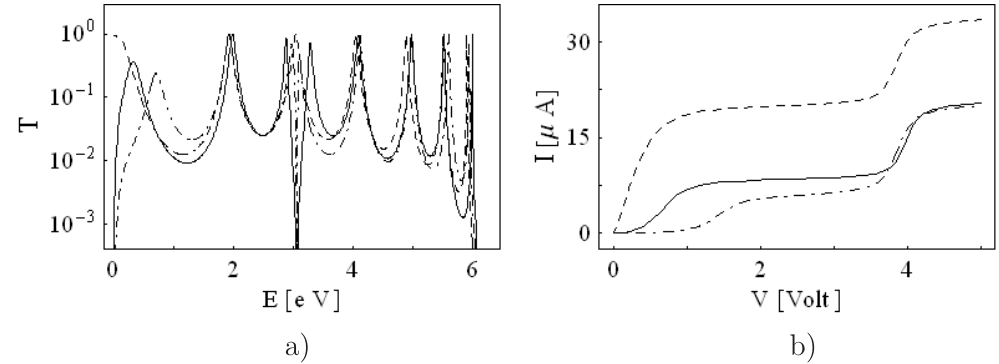
Fig. 5 Comparison of (a) transmission functions T ( E ) = T ( − E ) and (b) I-V characteristics I ( V ) = − I ( − V ) for three different devices (the sort of the line coincides with substituent position,